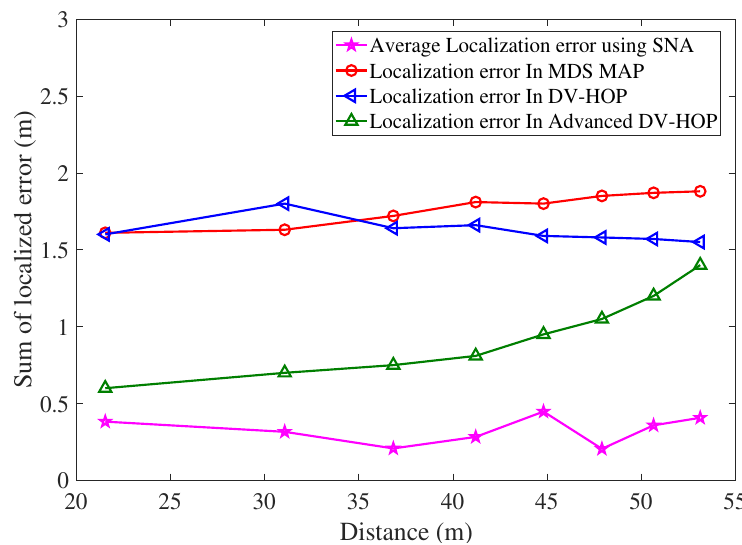
Figure 12. Comparison of SNA based localization error to existing